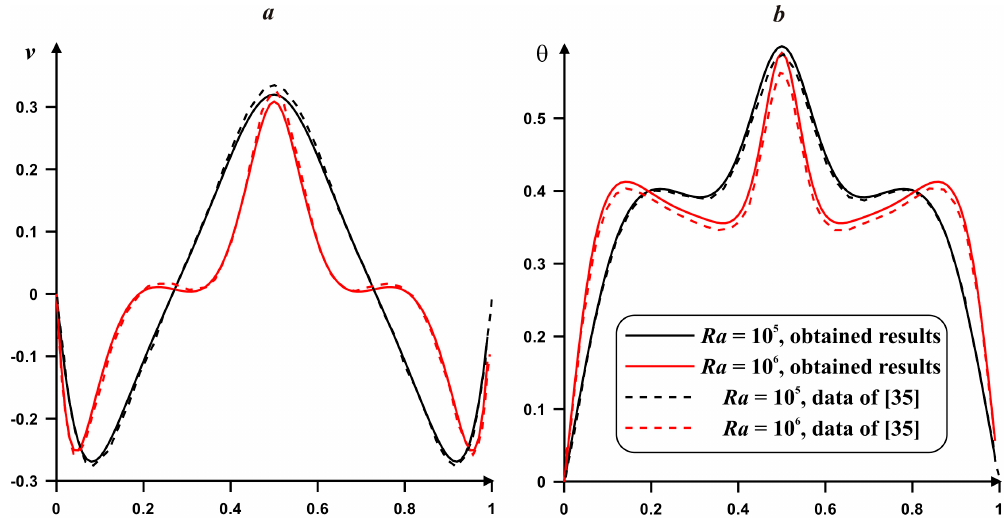
Figure 2. Velocity and temperature profiles in comparison with numerical data of AlAmiri et al. [35] for different Ra : ( a ) vertical velocity profiles; ( b ) temperature profiles.